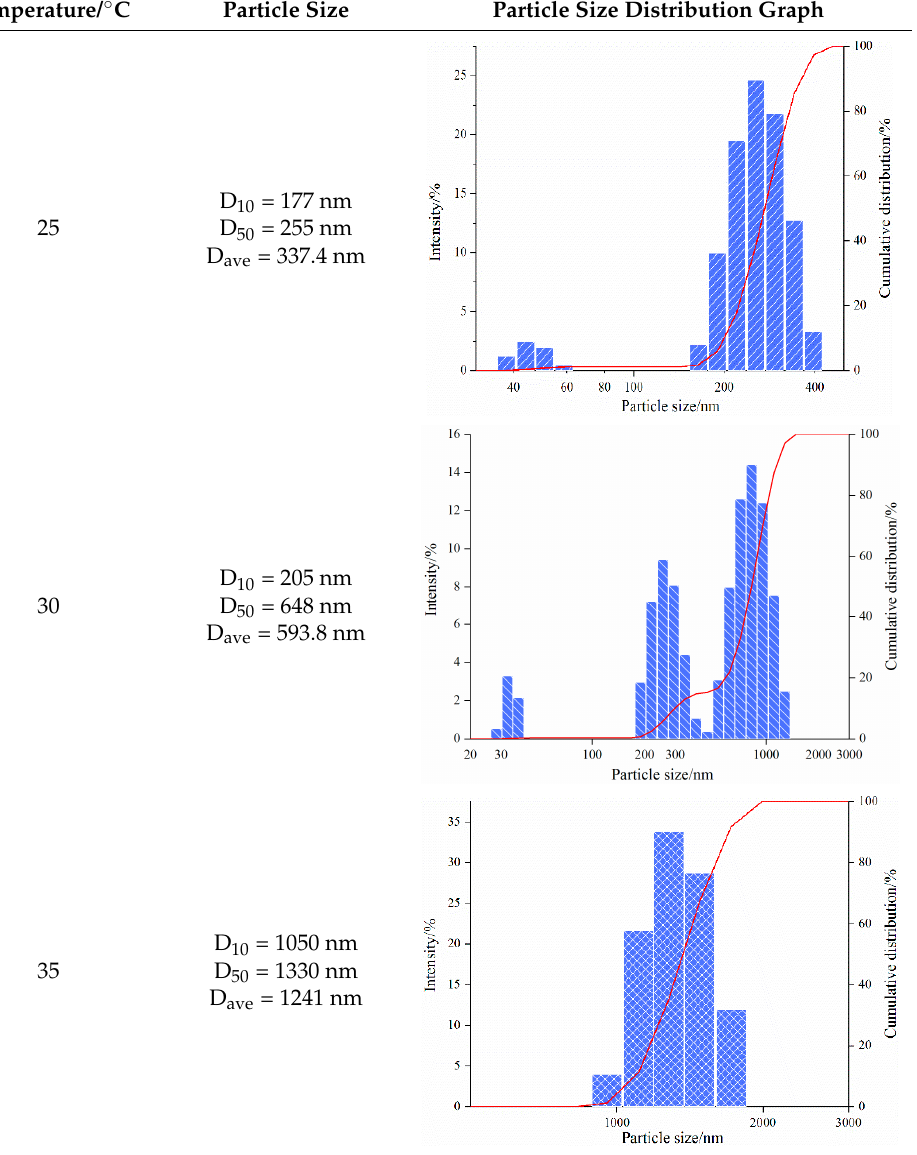
Figure 10. PNBAM aqueous solution graphs at 25, 30, and 35 °C.